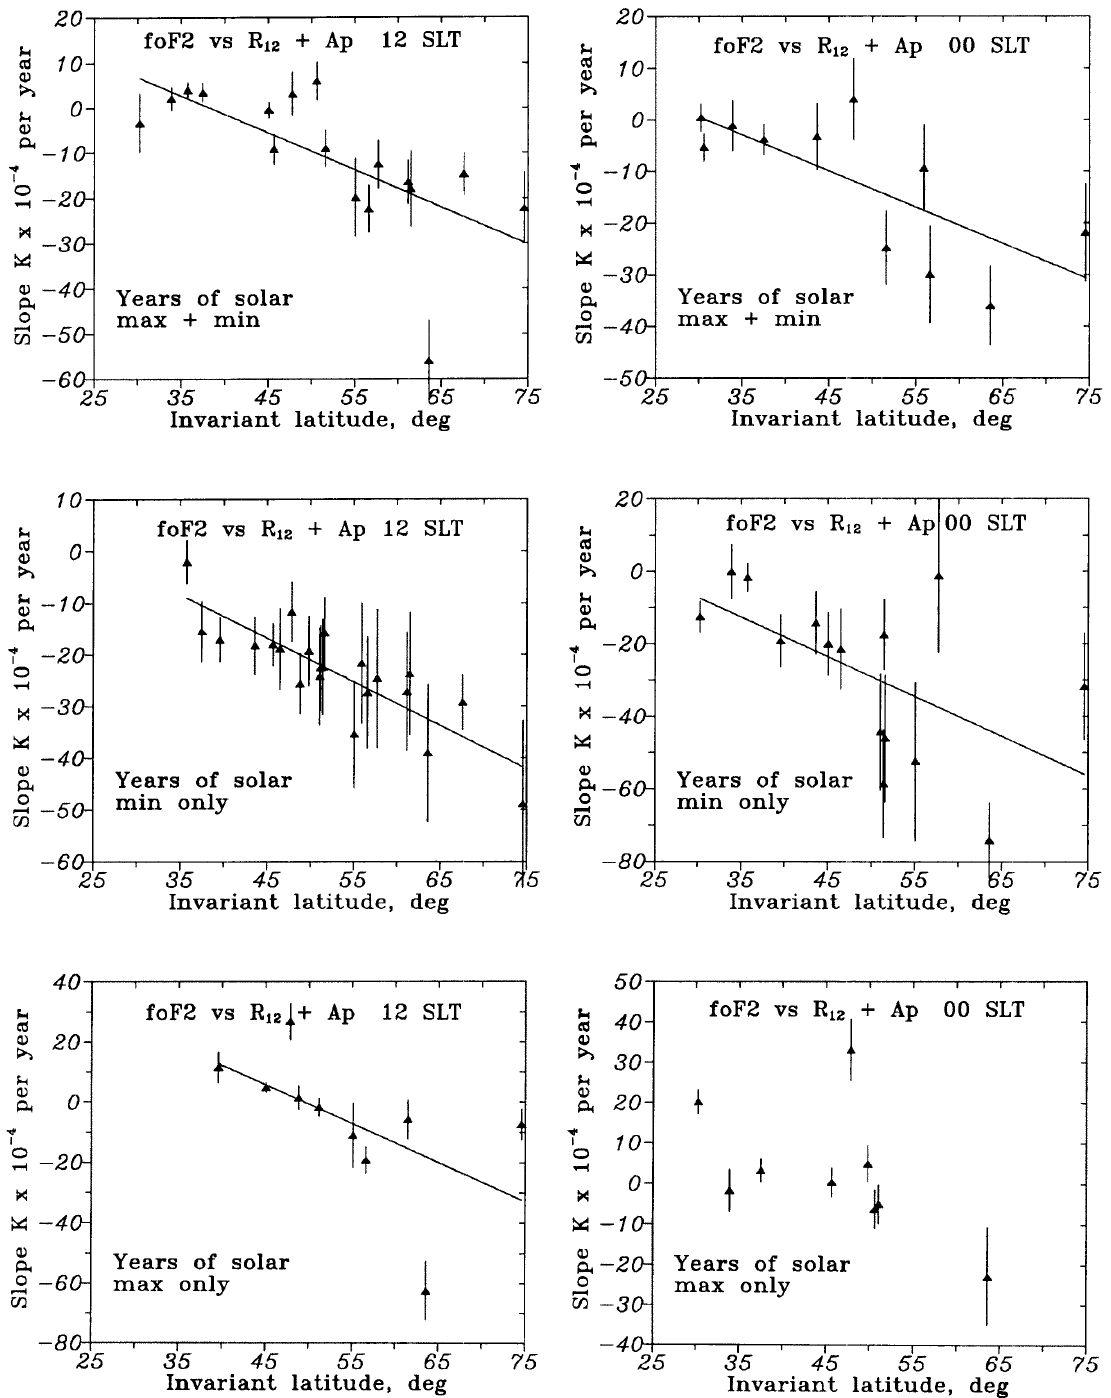
Fig. 3. Same as Fig. 1 but for model 2 ( f oF2 versus R